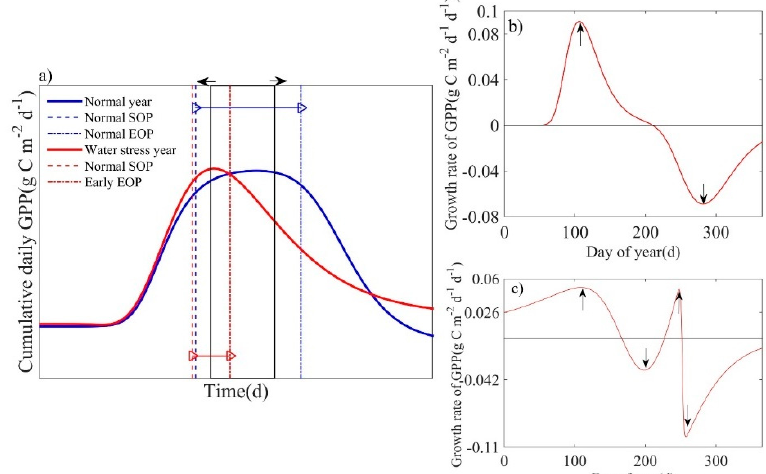
Figure 4. Schematic diagram of: ( a ) pattern of modeled cumulative daily GPP, solid black rectangle represents the standard length of peak (LOP) threshold (60 d), blue double-headed arrow indicates the normal LOP (>60 d), and the red double-headed arrow indicates the water-limitation induced short LOP (<60 d); and characteristic GPP growth rate in ( b ) normal year (2013) (black arrow point at the local extrema), with one maximum and minimum peak value (0.09 and − 0.06 g C m − 2 d − 1 d − 1 , respectively), and ( c ) short-term, summer drought year (2010), with multiple maximum and minimum peak values.